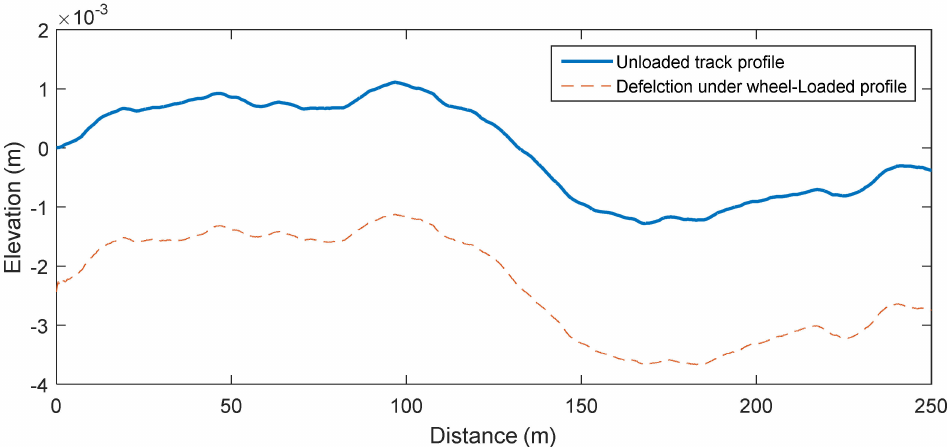
Figure 5. Comparison of the track unloaded and loaded